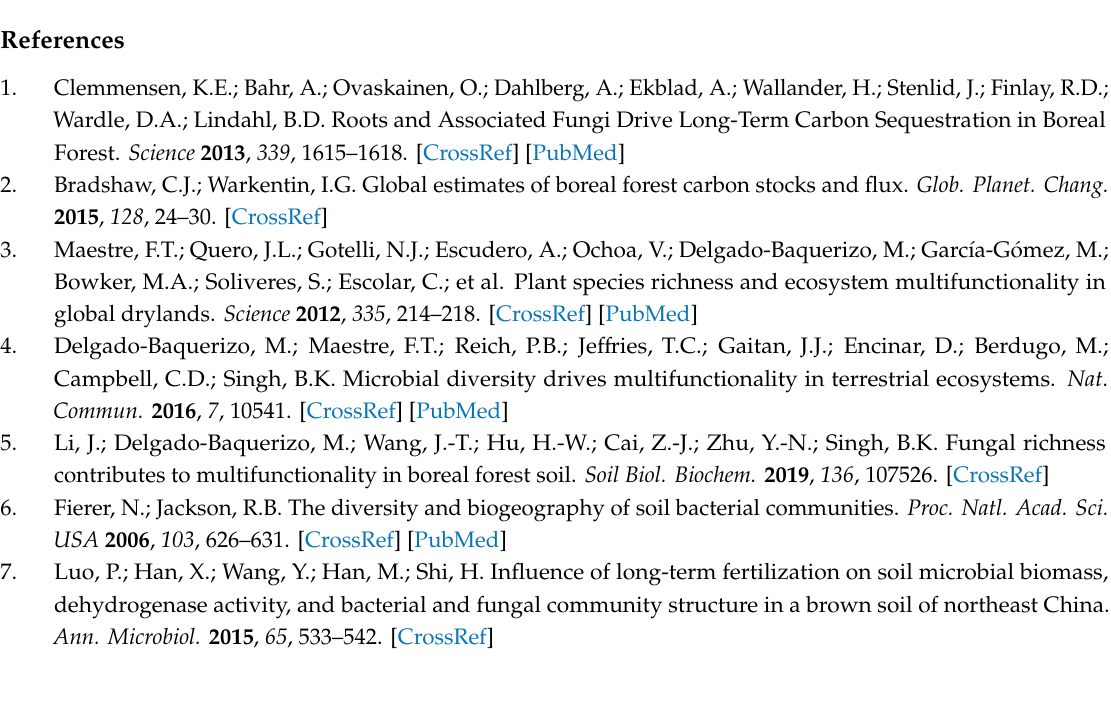
Figure S1.1: Visualization of the elbow (a) and variance explanation percentage (b) to establish the number of dimensions to be retained in the PCA of ecosystem function variables., Figure S1.2: Visualization of the elbow (a) and percentage of explanation of variance (b) to establish the number of dimensions to be retained in the PCA of environmental variables., Figure S1.3: PCA of abiotic variables measured in the boreal forest to perform a grouping., Figure S2.1: GLM of fungal alpha ( α ) and beta ( β ) biodiversity and abiotic environment variables., Figure S2.2: GLM of bacterial alpha ( α ) and beta ( β ) biodiversity and abiotic environment variables., Figure S2.3: GLMs explanation comparison with and without random variables of bacterial and fungal alpha ( α ) and beta ( β ) biodiversity and biotic environment variables., Table S1.1: Ecosystem functioning variables., Table S1.2: Abiotic variables., Table S3.1: Fungal SEM regressions correlations coe ffi cients values., Table S3.2: Bacterial SEM regressions correlations coe ffi cients values., Table S3.3: Multifunctionality SEM regressions correlations coe ffi cients